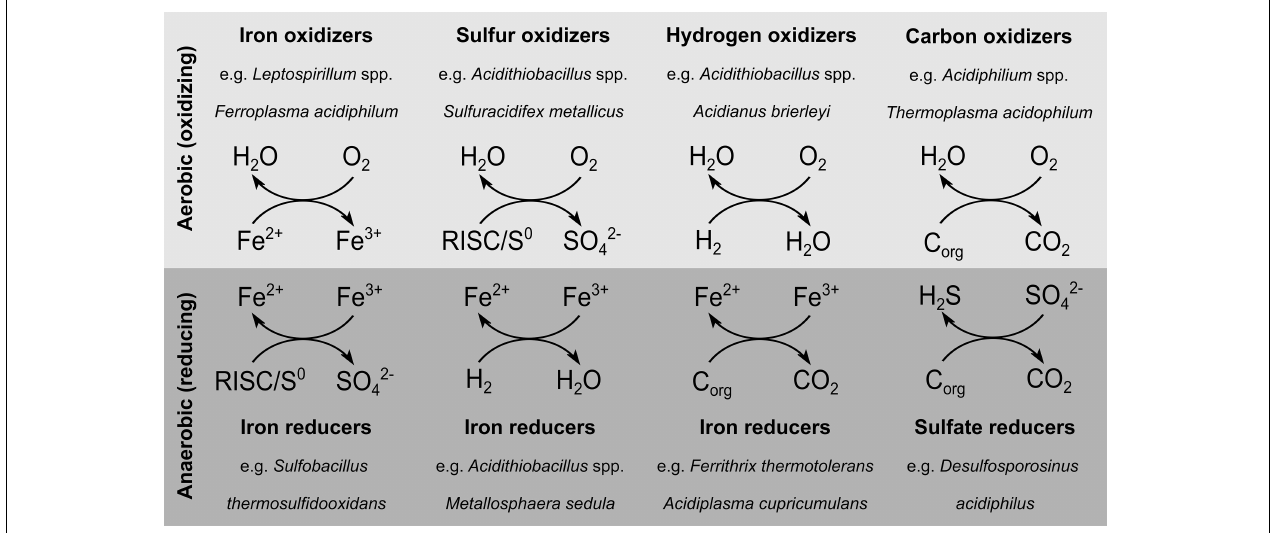
FIGURE 1 | Diversity of dissimilation pathways used by acidophiles. The underlying data can be found in the associated studies (Hedrich et al., 2011; Hedrich and Johnson, 2013b; Dopson, 2016). RISC, reduced inorganic sulfur compounds; C org , organic